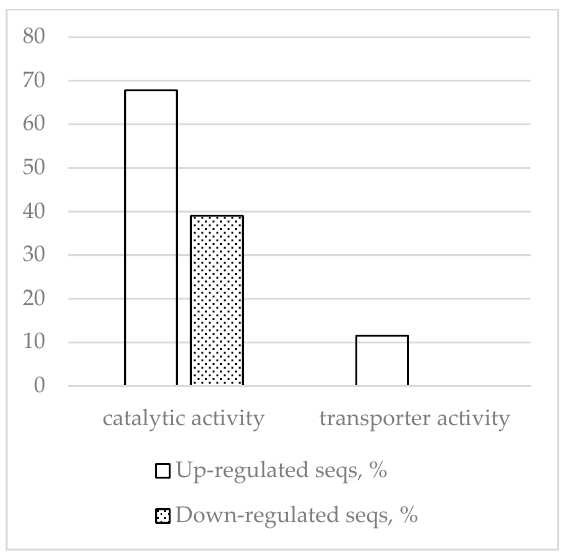
Figure 5. Molecular functions with most up- and downregulated DEGs (inoculation/wounding vs. control) determined by Fisher’s exact test using p < 0.05 as the threshold.